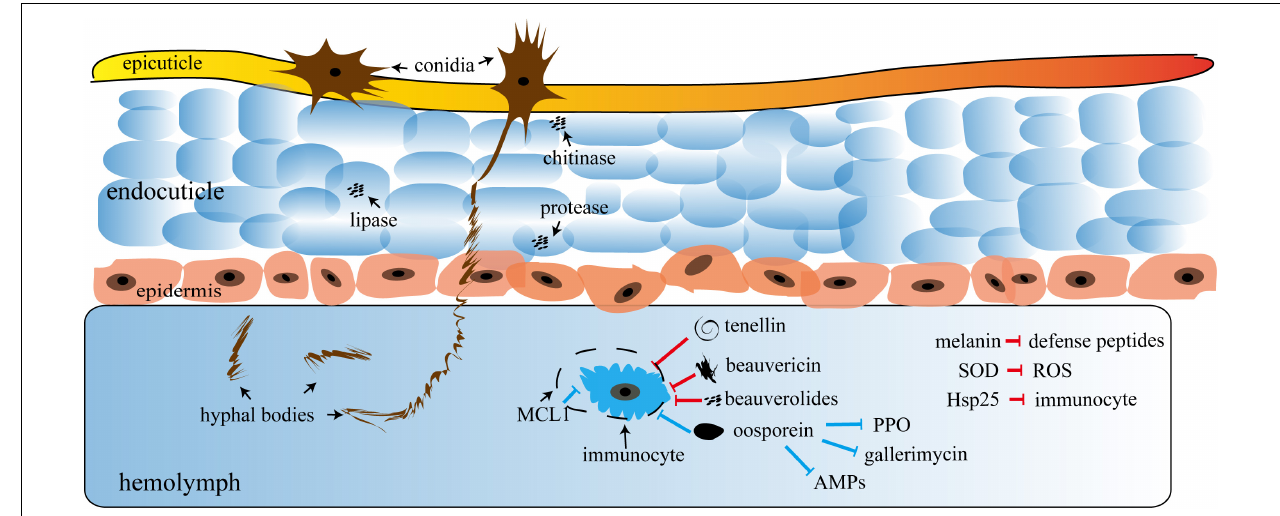
FIGURE 1 | A schematic of fungal invasion. AMPs, antimicrobial peptides; PPO, polyphenol oxidase; MCL1, myeloid cell leukemia sequence, an antiapoptotic protein; SOD, superoxide dismutase; ROS, reactive oxygen species; Hsp25, heat shock factor 25. The conidia firstly penetrate the epicuticle to reach the endocuticle of the insect and then release plenty of hydrolases, including chitinase, protease, and lipase, to rapidly disintegrate the cuticle for more conidia intrusion. Hyphal bodies that pass through the epidermis intrude into the hemolymph of the insects and secrete plenty of insecticidal substances, such as oosporein, beauvericin, beauverolides, and tenellin, most of which either suppress the immunocyte or directly destroy the hemolymph. The substances mentioned in the bottom right of the figure suppress the immune system. The red and blue arrows represent the direct and indirect inhibition responses,